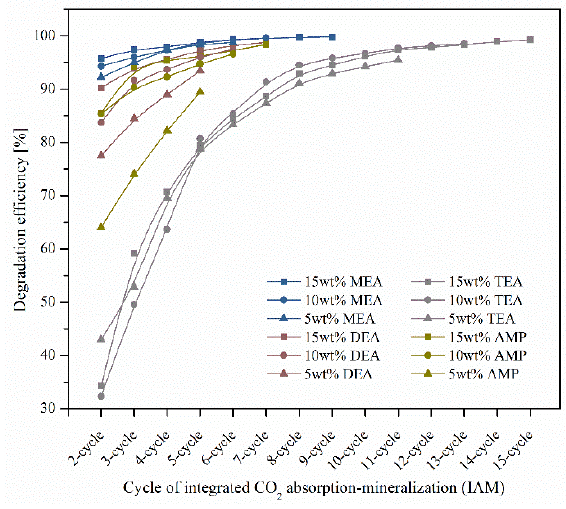
Figure 7. Degradation efficiency of 5, 10, and 15 wt.% MEA, DEA, TEA, and AMP absorbents in multicycle IAM.